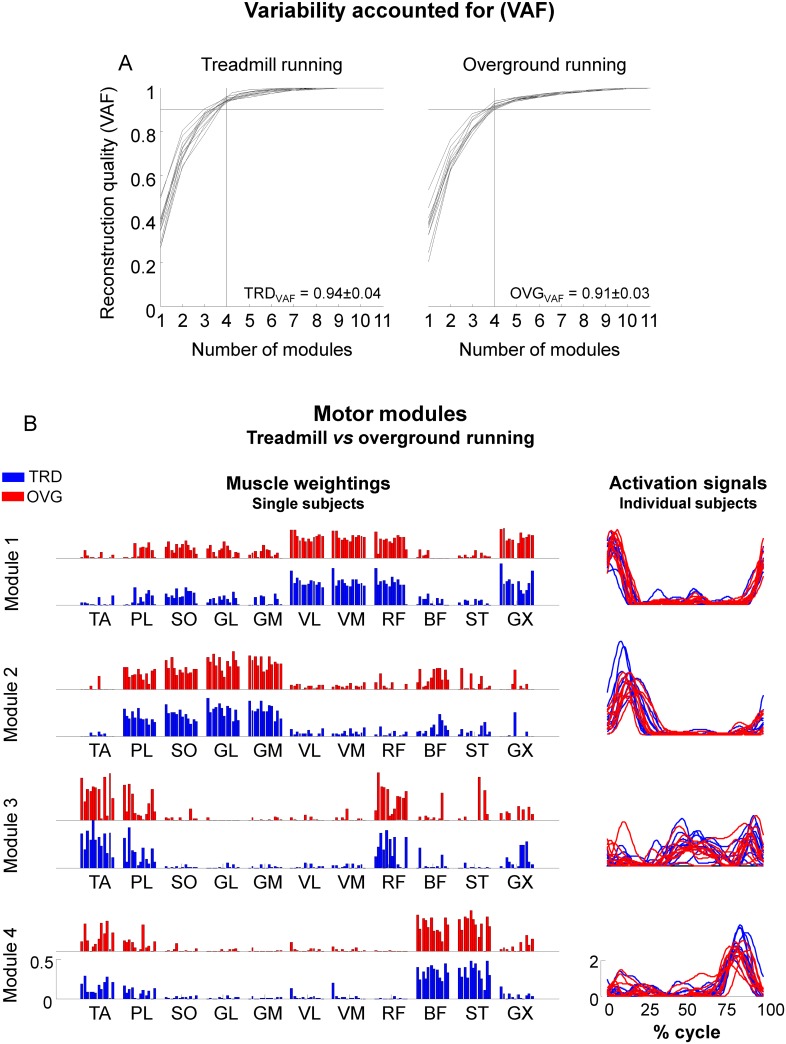
Motor modules—Running.Reconstruction quality of surface EMG signals (variation accounted for—VAF) by means of different number of motor modules (A) for each subject separately. The horizontal solid line in each panel corresponds to VAF at 0.9, and the vertical solid line correspond to the extraction of four motor modules. Mean±SD VAF for each condition and EMG processing method is displayed in the panels. We did not observe differences between locomotion conditions (treadmill vs overground running). In B, motor modules extracted from 20 consecutive gait cycles from treadmill running (blue) and overground running (red) are displayed for all subjects (individual bars of the muscle weightings and lines of the activation signals).